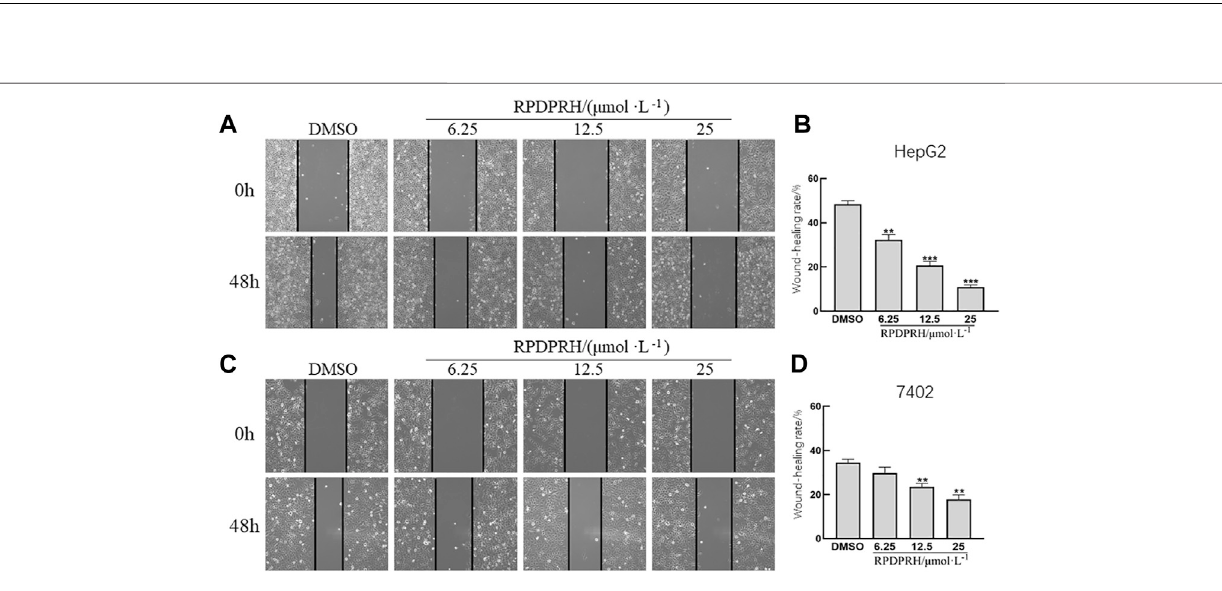
FIGURE 3 | Effect of RPDPRH on HepG2 and 7402 cell migration. Note: (A) Image of the wound healing assay in HepG2 cells. (B) Relative wound healing rate in HepG2 cells. (C) Image of thewound healing assayin 7402 cells. (D) Relative wound healing ratein 7402cells. Compared with theDMSO controlgroup, ** p < 0.01and *** p < 0.001, (×100, ‾ x ± s,